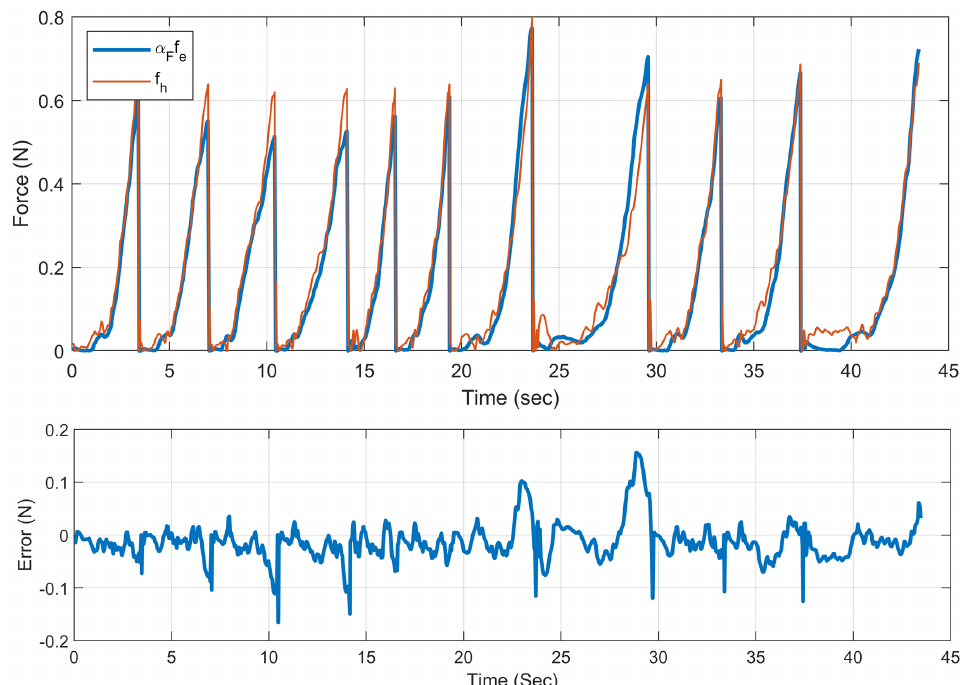
Figure 11. Force–time profile of the scaled actual needle–tissue interaction forces recorded by the F/T sensor under the tissue versus the user received